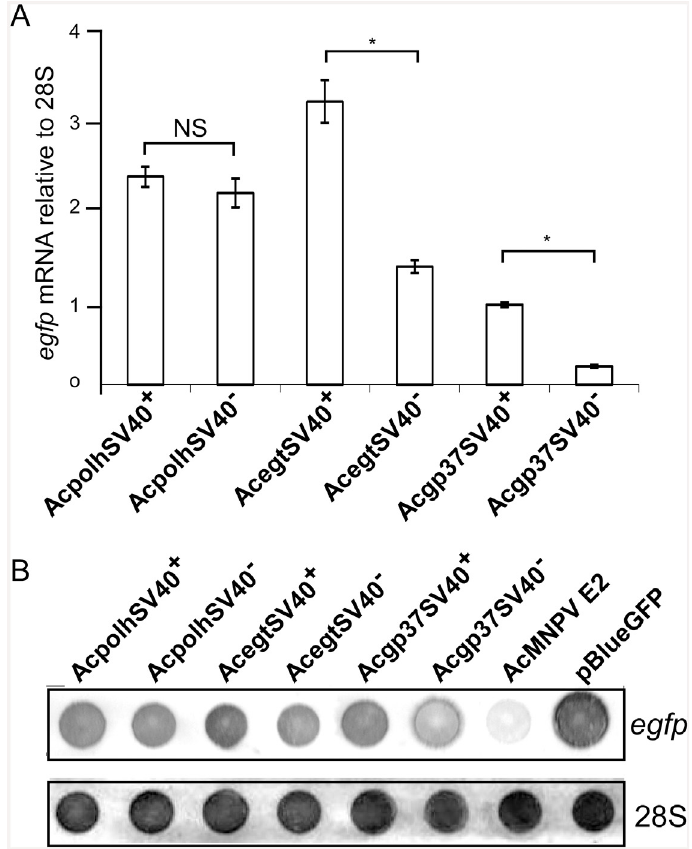
Fig 3. Transcription analysis of egfp from different viral infections. Real-time quantitative reverse transcription PCR analysis of egfp . Viral constructs with or without the SV40 polyA signal were used to infect Sf21 cells and the infected cells were harvested at 48 h p. i. for total RNA extraction. Equal amounts of RNA from different viral cell infections were used as templates for amplification of a 153 bp amplicon of the egfp gene using SYBR green dye RT-PCR kit from Bio-Rad for real-time quantification of the egfp transcripts. Sf21 cellular 28S rRNA gene was used as a house keeping gene in the real-time qPCR to normalize the reaction. Error bars represent SD from three independent cell infections. B . Dot-blot analysis of egfp transcripts. Total RNA (2 μ g) from the Sf21 cells infected with AcMNPV with or without the SV40 polyA signal as well as the wt AcMNPV (negative control) and a plasmid pBlueGFP (positive control) were blotted to a nylon membrane and probed with either a egfp or 28S rDNA fragment labeled with biotin.